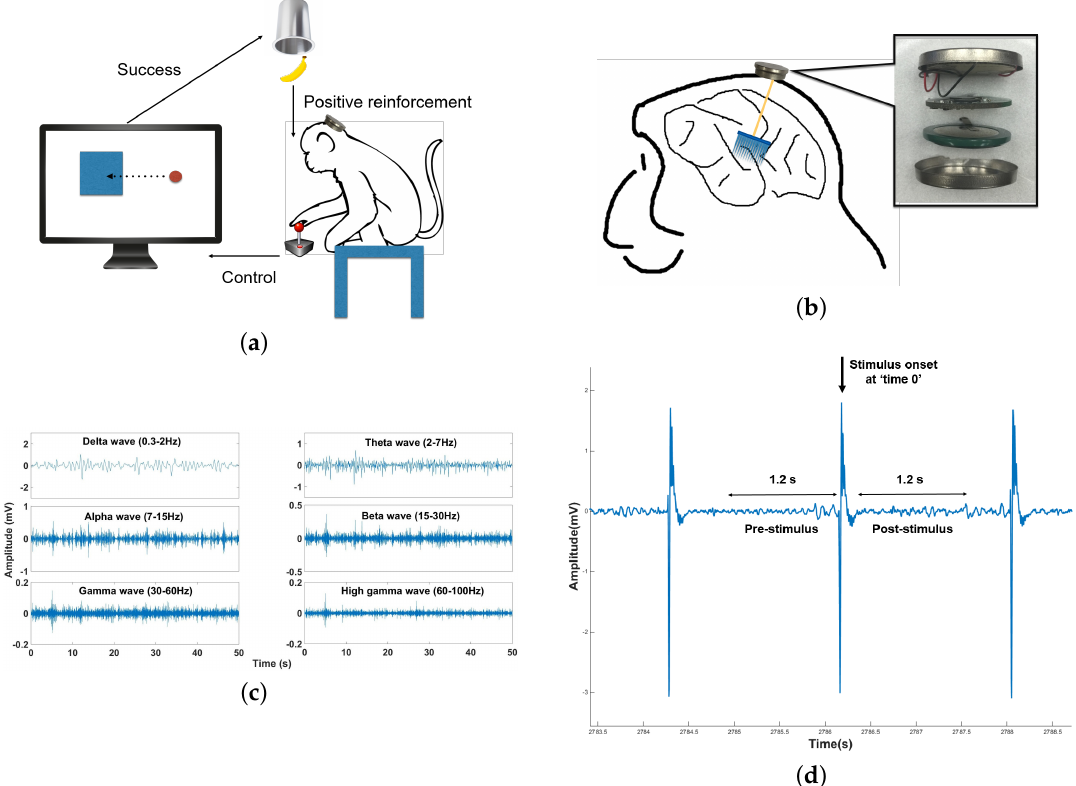
Figure 6. ( a ) Experimental setup for the in vivo test. ( b ) Implantable BBMI module connection to the Utah Array. ( c ) Different brain rhythms of the local field potential (LFP) recorded from the Monkey’s motor cortex. ( d ) Recorded stimulation artifacts.